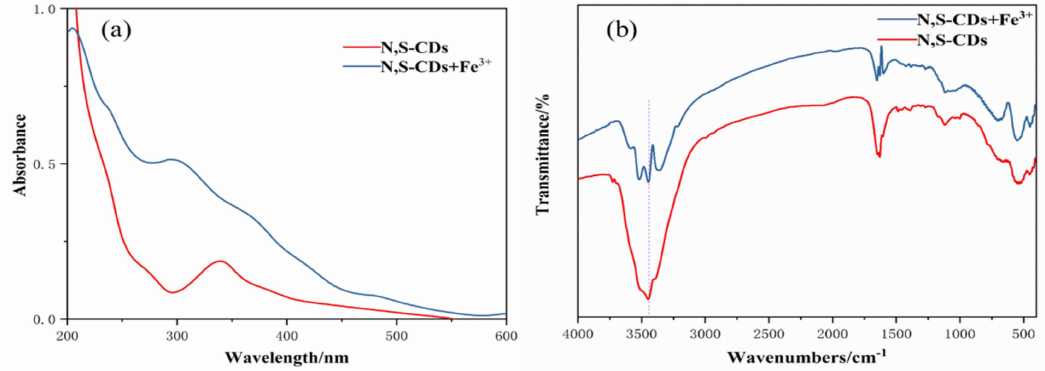
Figure 8. UV spectra ( a ) and infrared spectra ( b ) of N,S-CDs+Fe 3+ system and